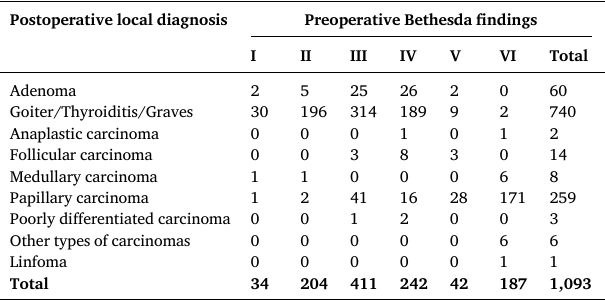
Table 1 Association of preoperative FNAB Bethesda classi fi cation and local diagnosis at the fi nal pathological